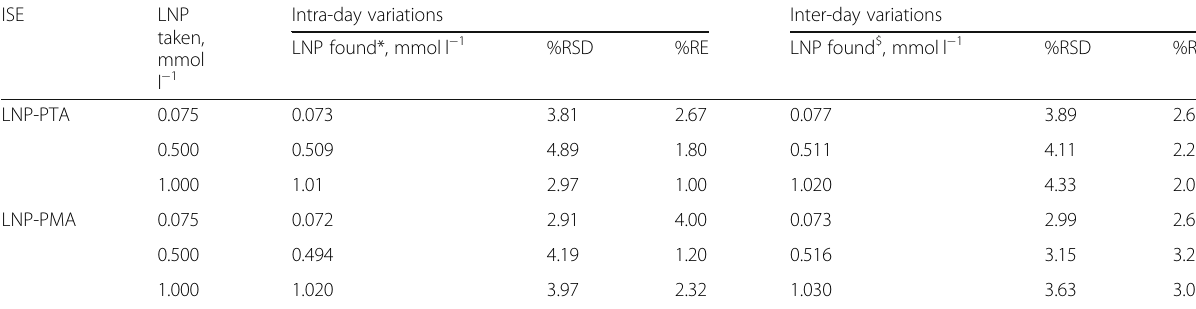
Table 4 Results of intra- and inter-day precision and accuracy ISE LNP taken,